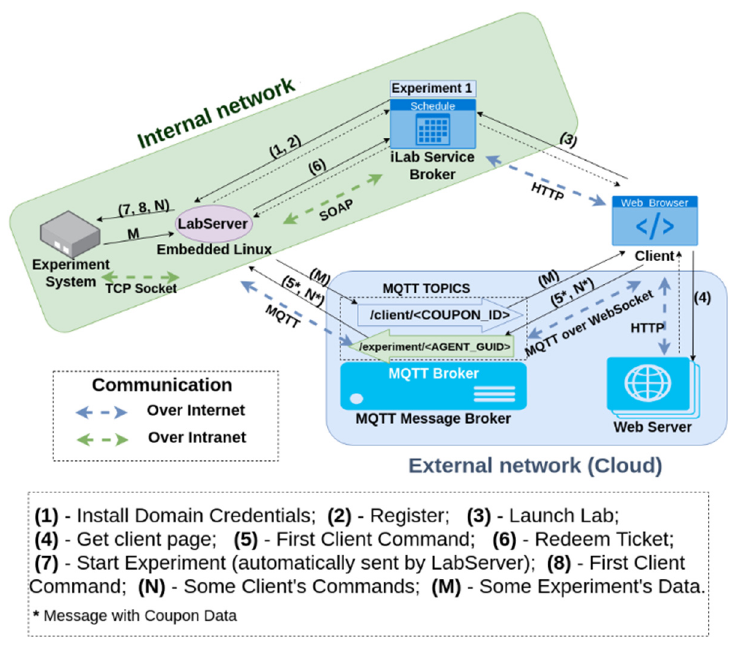
Figure 10. ELSA ‐ SP structure (adapted from [62]). Figure 10. ELSA-SP structure (adapted from